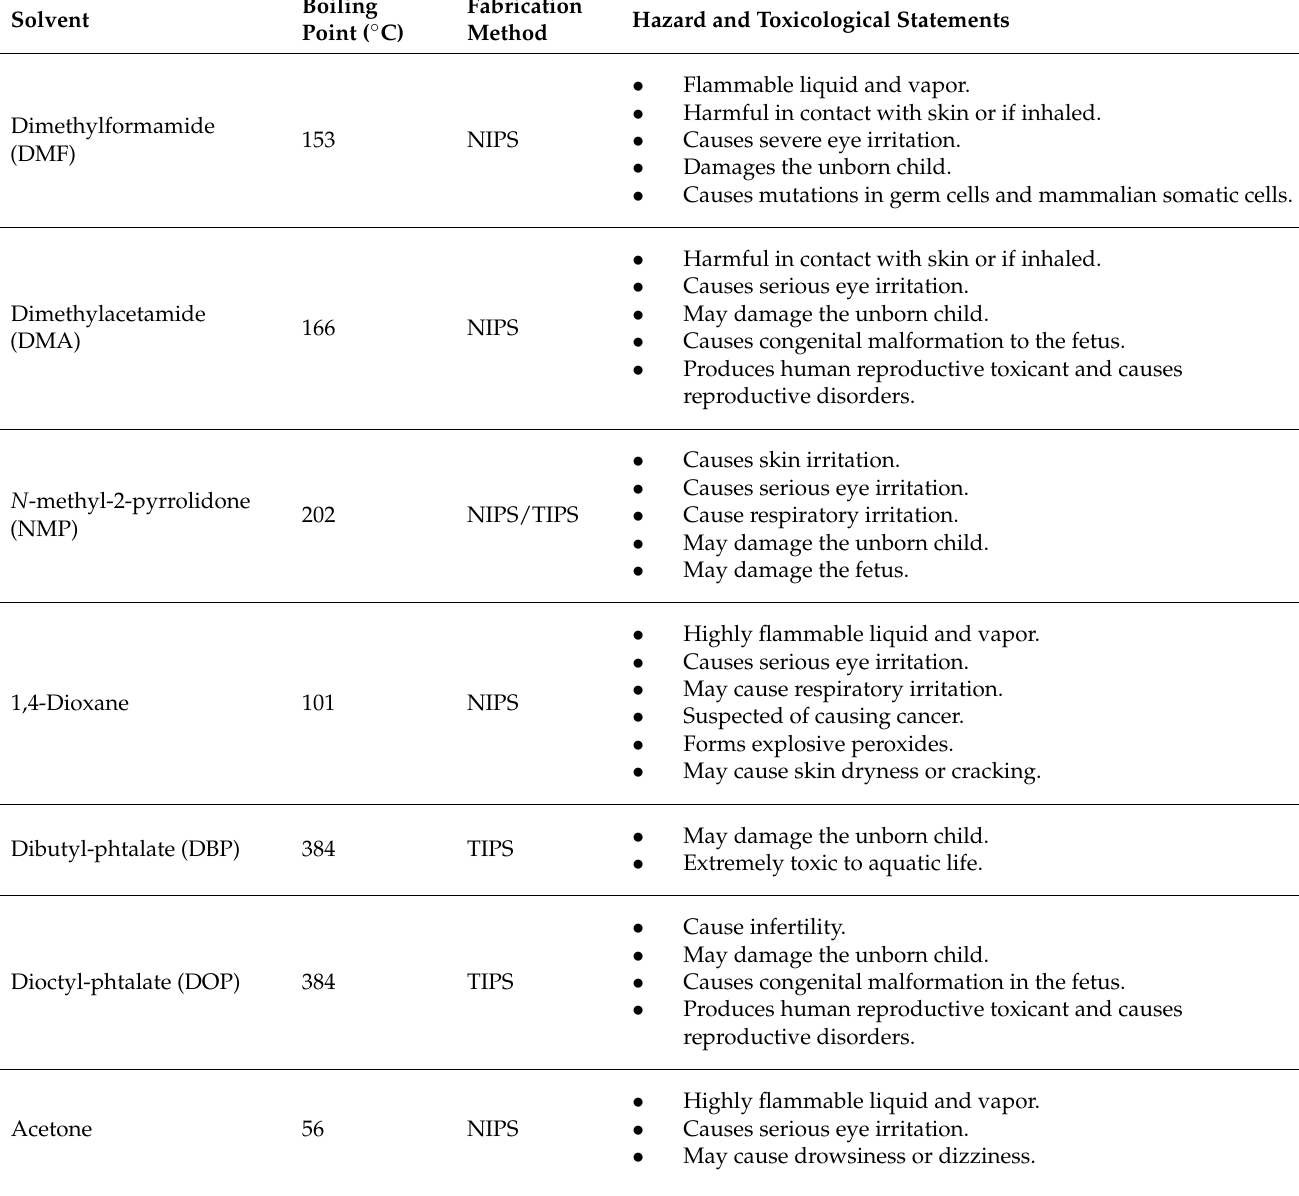
Table 1. Hazard classification of the solvents commonly used for substrate fabrication